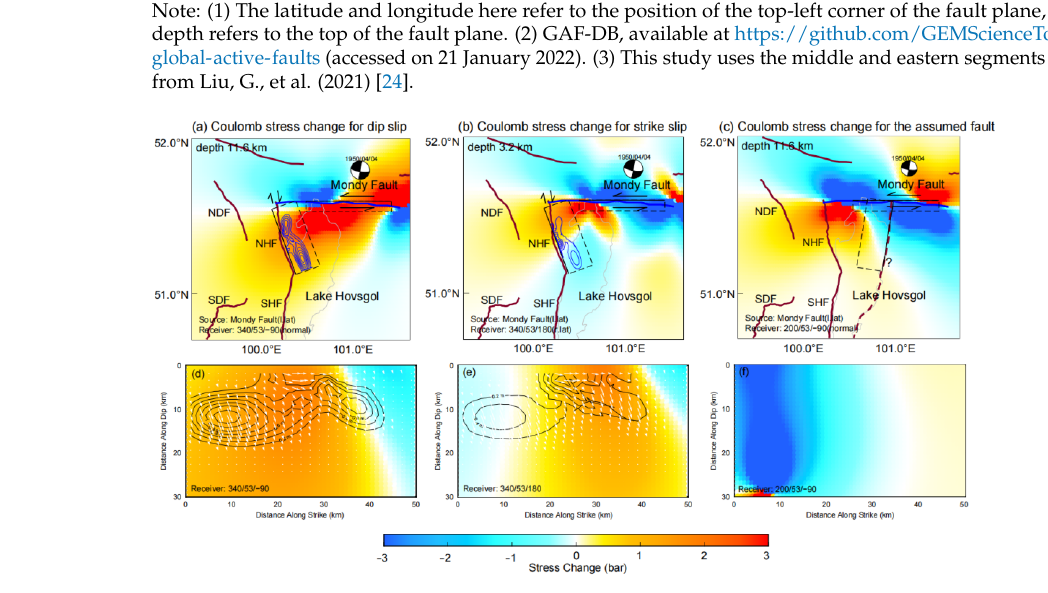
Figure 5. Stress change analysis based on a simple dislocation model applied to the Mondy Fault, indicated by the blue line [24]. Warm (cold) color means facilitating (inhibiting) slips on the receiver faults. The beachball displays the focal mechanism of the 1950 Mw6.9 Mondy earthquake [39]. ( a – c ) Map views of the consequent Coulomb stress changes for purely dip and strike slips on the NHF and for normal slip on an assumed west ‐ dipping fault east of Lake Hovsgol, respectively. For ( a ) and ( b ), the stress changes were calculated at the depths of 11.6 km and 3.2 km, respectively, where maximum dip and strike slips occurred in our slip model. The blue contours show the dip and strike slips, respectively. The depth for ( c ) is the same as in ( a ). The dark red dashed line represents the trace of the assumed west ‐ dipping normal fault. The black rectangles represent the surface outlines of the source and receiver faults, respectively, with solid lines showing the upper boundaries. ( d – f ) Coulomb stress changes on the receiver fault planes as ( a – c ). The black contours show the coseismic dip and strike slips, respectively. The white arrows represent the slip directions of the fault patches depicted in Figure 3. 4. Discussion The most prominent feature of the 2021 Mw6.7 Lake Hovsgol earthquake is the three asperities exhibiting distinct slip mechanisms at different depths on a single fault plane. It displays an interesting strain–release pattern starting from deep oblique slips in the south, drastically changing to the shallow right ‐ lateral slips in the middle, and ending up in oblique slips at depth again in the north. Our slip model was consistent with the results derived from descending InSAR and teleseismic data [24] but revealed more details of the slip partitioning pattern, particularly in the northern part of the fault, thanks to the addi ‐ tional constraints from ascending InSAR observations. Note that according to the ascend ‐ ing ALOS ‐ 2 InSAR data spanning about half a year after the earthquake, the slip distribu ‐ tion may contain the influence from postseismic deformation such as that from afterslip or poroelastic rebound. To probe the magnitude of postseismic deformation, we processed a pair of descending Sentinel ‐ 1 interferograms spanning the period of 19 January 2021–31 January 2021, which showed no obvious afterslip signal (Figure S7). Moreover, the largest aftershock, the 2021 Mw5.6 event, occurred in the ALOS ‐ 2 ascending time span, yet it did not cause any obvious deformation in the ascending Sentinel ‐ 1 observations either (Table 5; Figure S8). Therefore, we suggest that the observed slip partitioning pattern is domi ‐ nated by coseismic slips and that the influence from postseismic deformation is negligible.